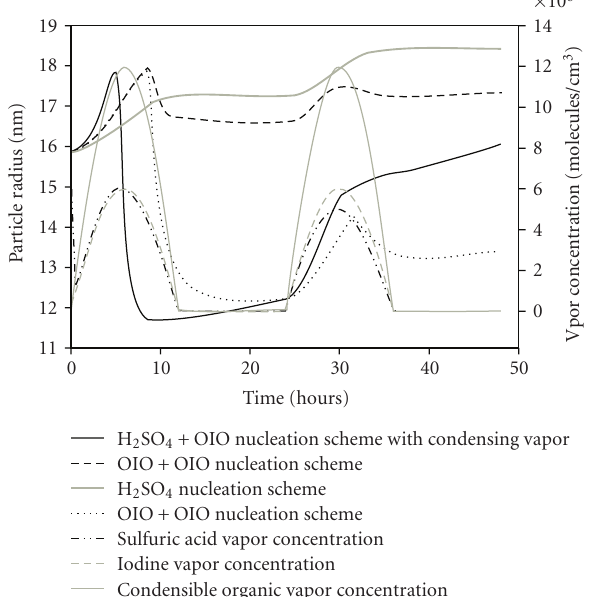
Figure 4: Comparison between aitken mode particle radii of the di ff erent nucleation schemes (on the left)